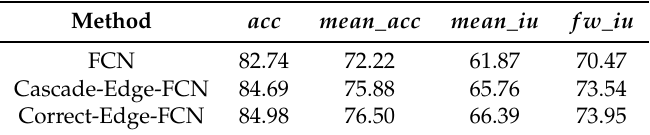
Table 3. Evaluation Results on ESAR. This table intuitively reflects the segmentation performance on ESAR dataset of the three algorithms as a whole.